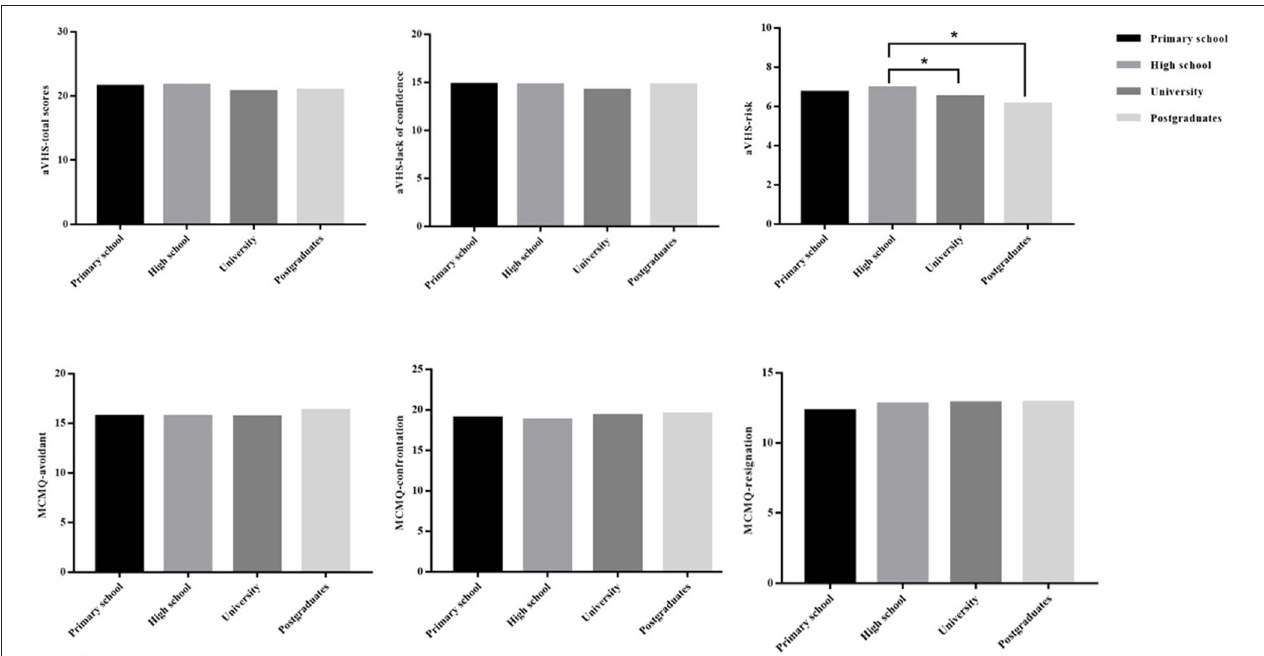
FIGURE 2 | Comparison of vaccine hesitancy and coping styles of NMOSD patients according to level of education. * P < 0.05.